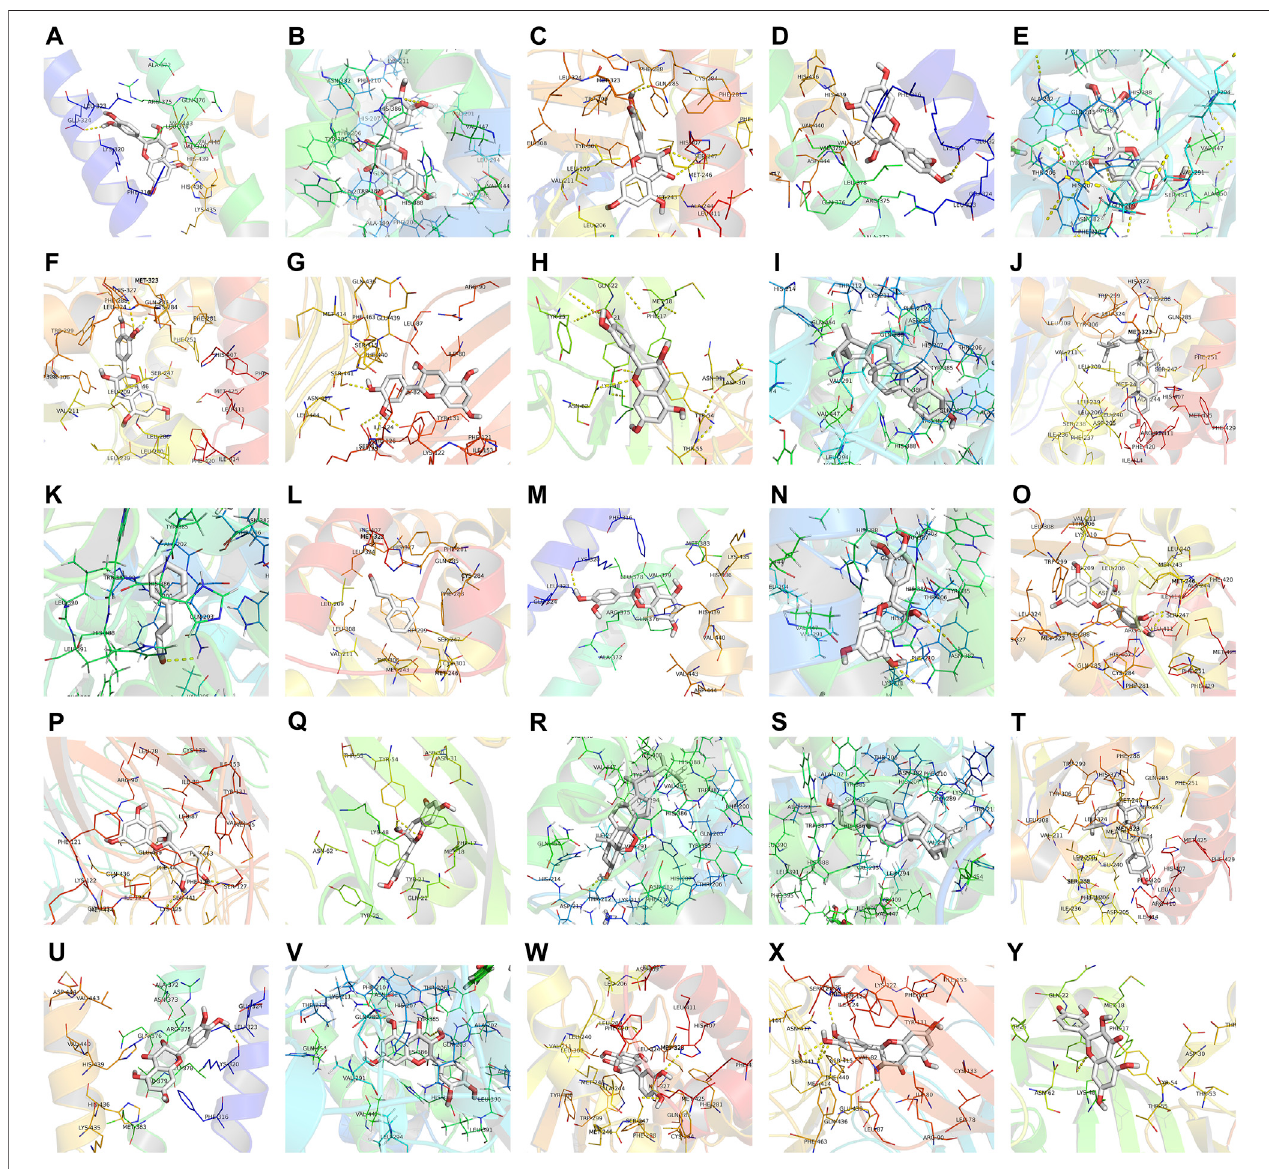
FIGURE 7 | The binding site of the main active components of Guizhi and the key targets. The molecular docking poses of (-)-taxifolin-APP (A) , (-)-taxifolin- PTGS2 (B) , (-)-taxifolin-SRC (C) , (+)-catechin-APP (D) , (+)-catechin-PTGS2 (E) , (+)-catechin-SRC (F) , (+)-catechin-TLR4 (G) , (+)-catechin-VEGFA (H) , beta-sitosterol- PTGS2 (I) , beta-sitosterol-SRC (J) , cinnamaldehyde- PTGS2 (K) , cinnamaldehyde-SRC (L) , ent-Epicatechin-APP (M) , ent-Epicatechin-PTGS2 (N) , ent-Epicatechin- SRC (O) , ent-Epicatechin-TLR4 (P) , ent-Epicatechin-VEGFA (Q) , peroxyergosterol-PTGS2 (R) , sitosterol-PTGS2 (S) , sitosterol-SRC (T) , taxifolin-APP (U)